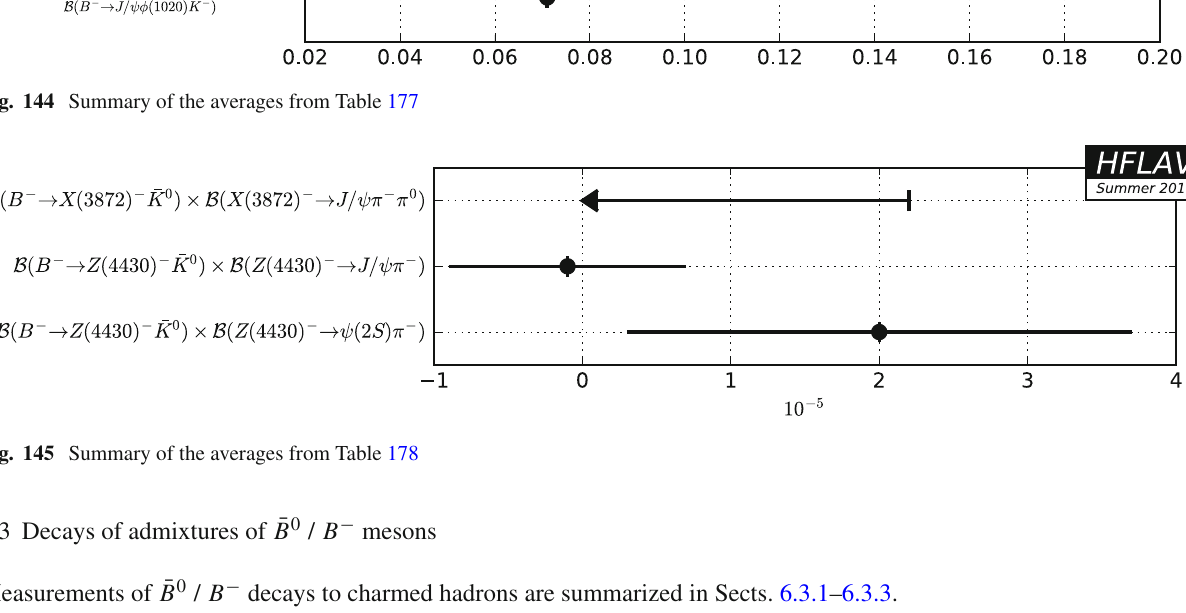
Fig. 145 Summary of the averages from Table 178 ¯ B 0 / B − mesons 6.3 Decays of admixtures of ¯ B 0 / B − decays to charmed hadrons are summarized in Sects. 6.3.1–6.3.3. Measurements of